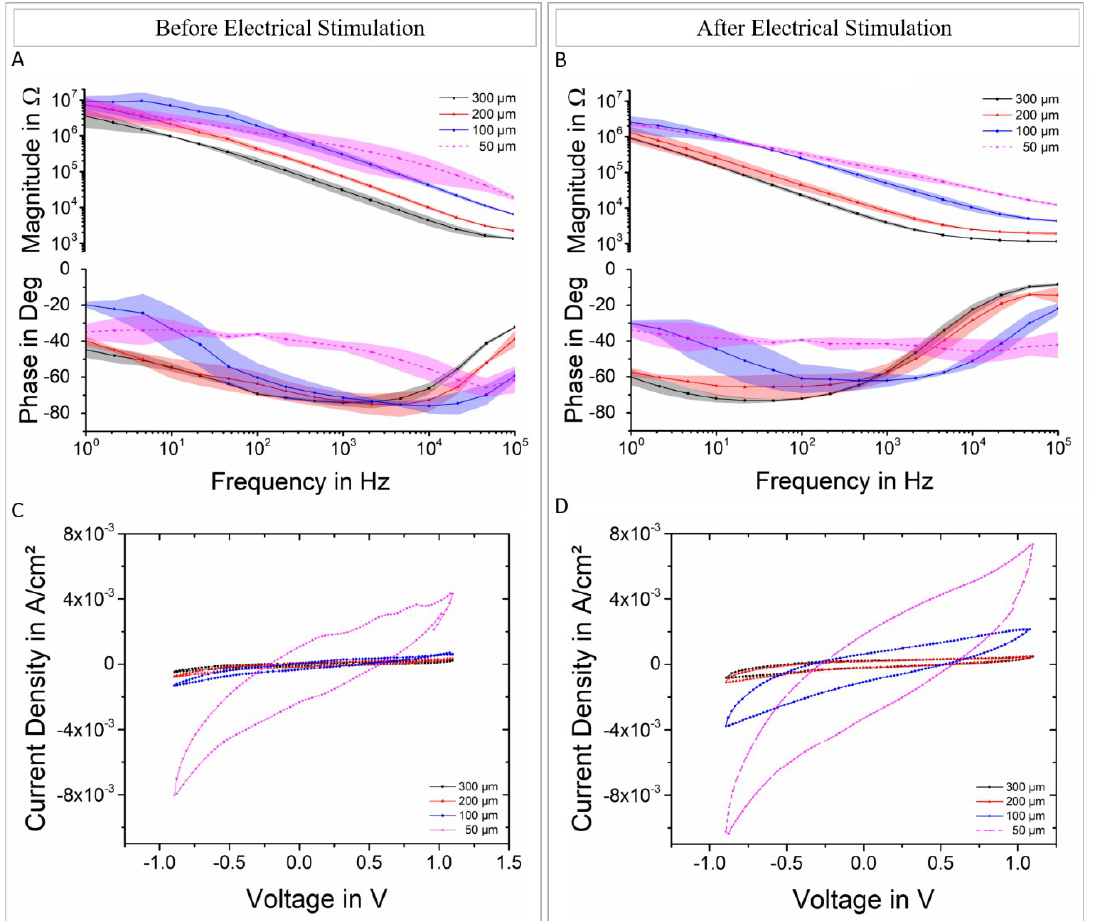
Figure 5. EIS (N = 4) and CV (representative cases) plots before ( A , C ) and after ( B , D )